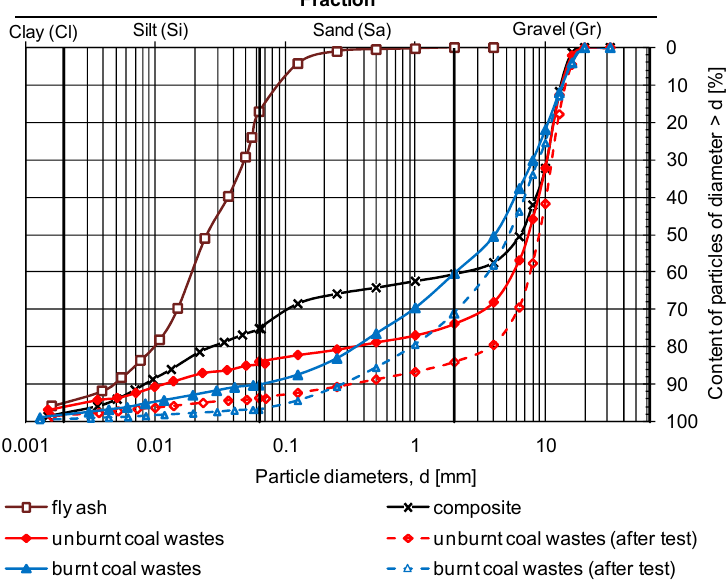
Figure 3. Grain size curves of the materials.